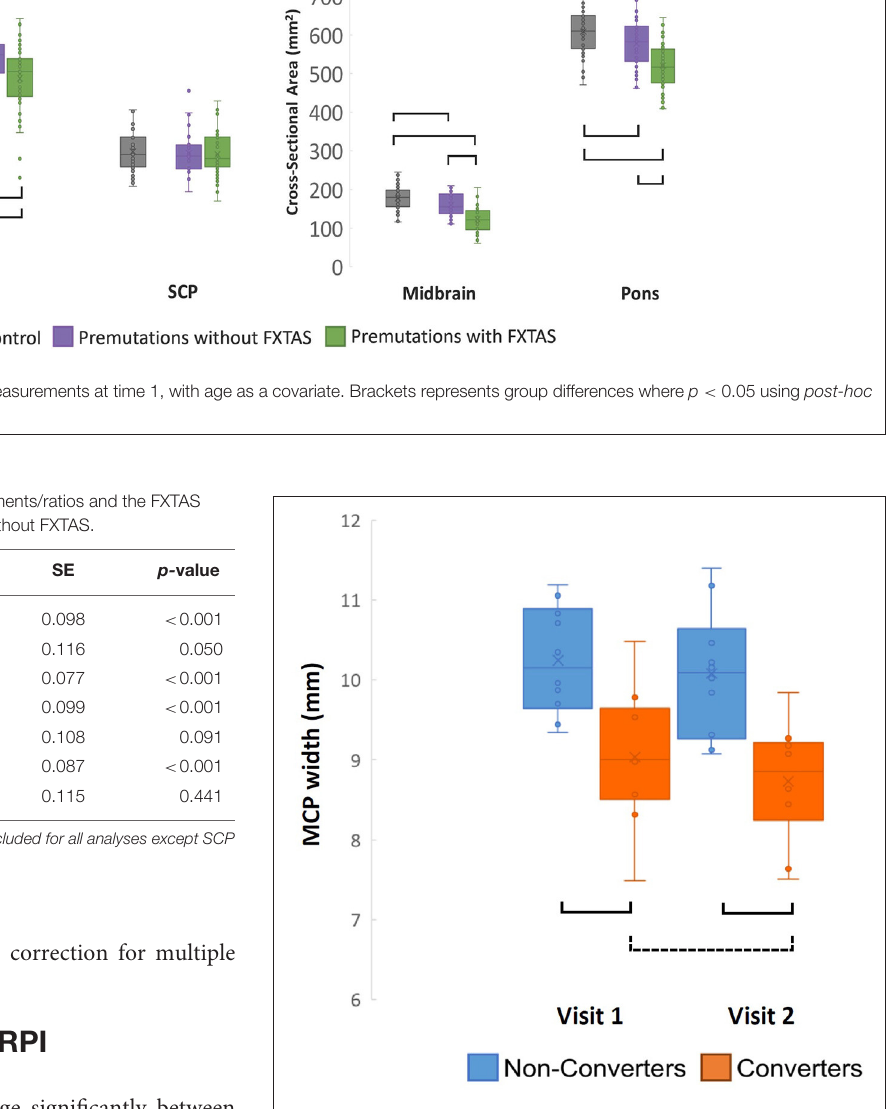
FIGURE 3 | Converter and non-converter group comparison of MCP width over time. Solid lines represent p < 0.007 and surviving Bonferroni correction for multiple comparisons, while the dotted line represents p < 0.05 and not surviving Bonferroni